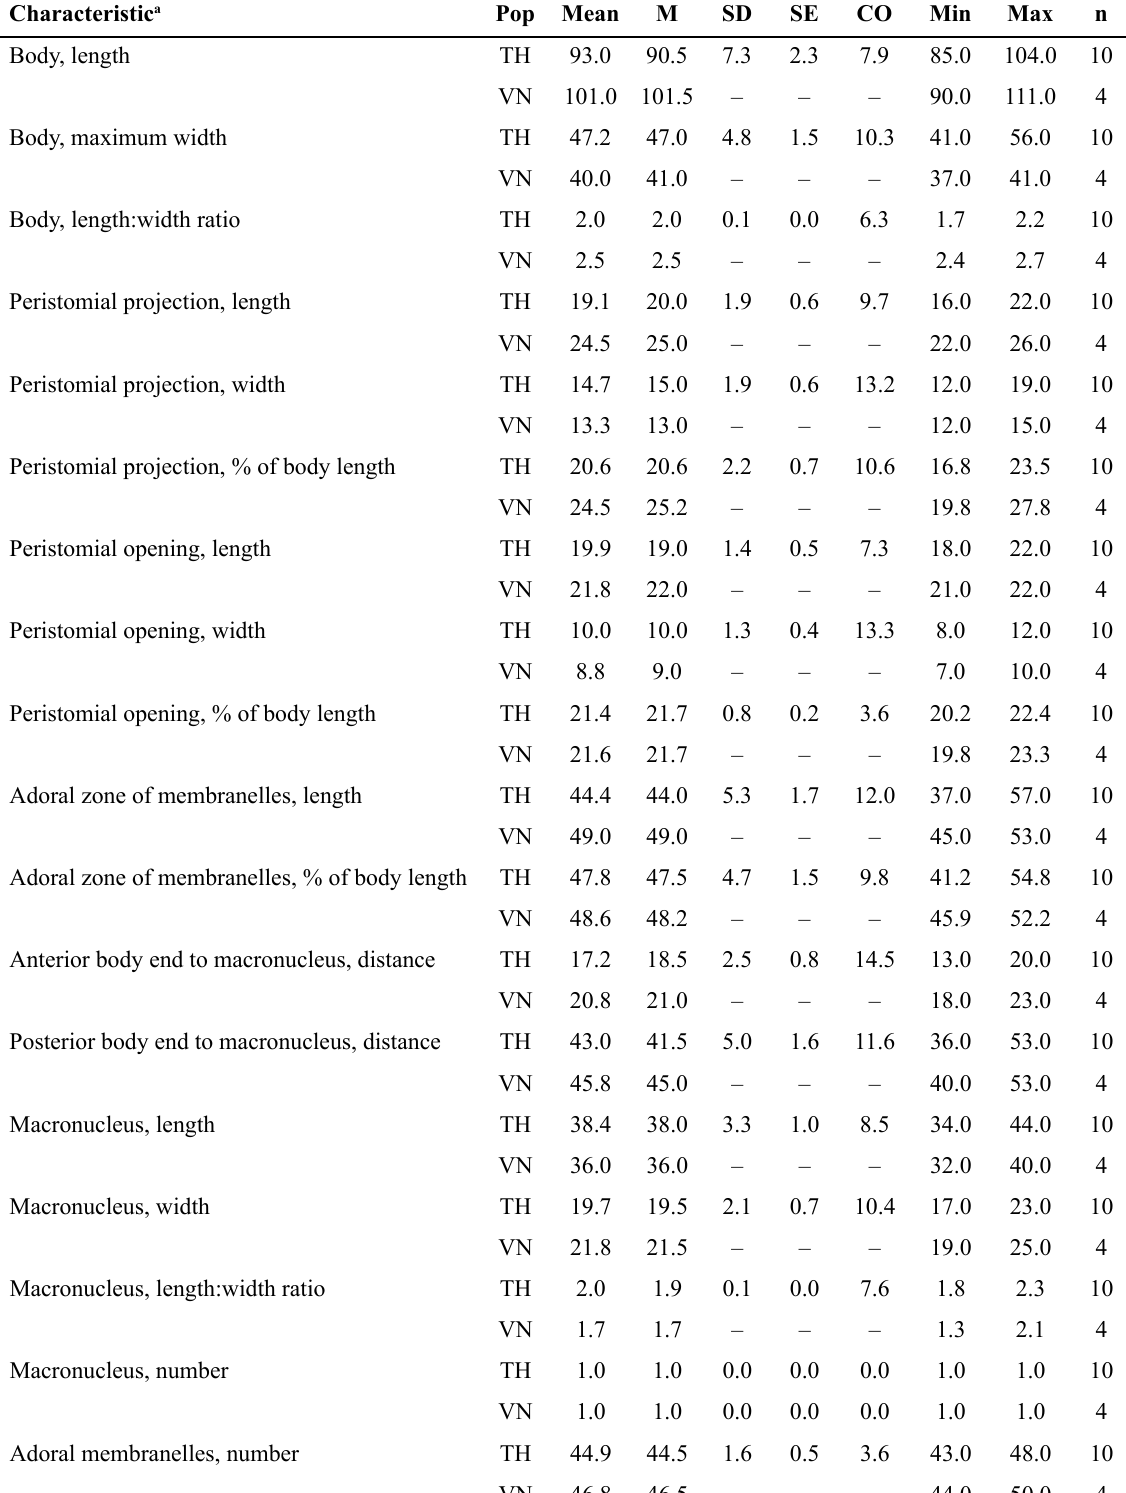
Table 3. Morphometric data on Clevelandella panesthiae (Kidder, 1937) from Thailand and Vietnam. Characteristic